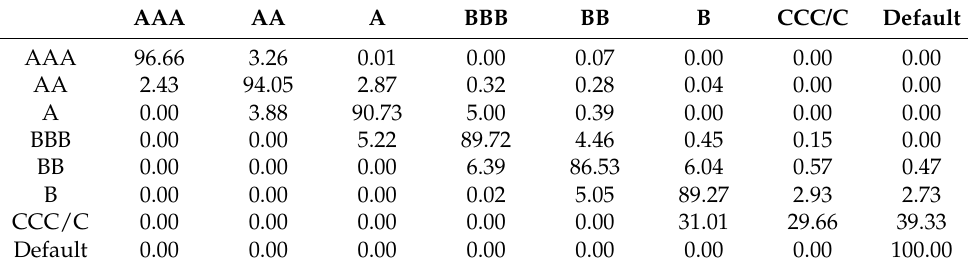
Table 2. The normalized one-year transition matrix (in